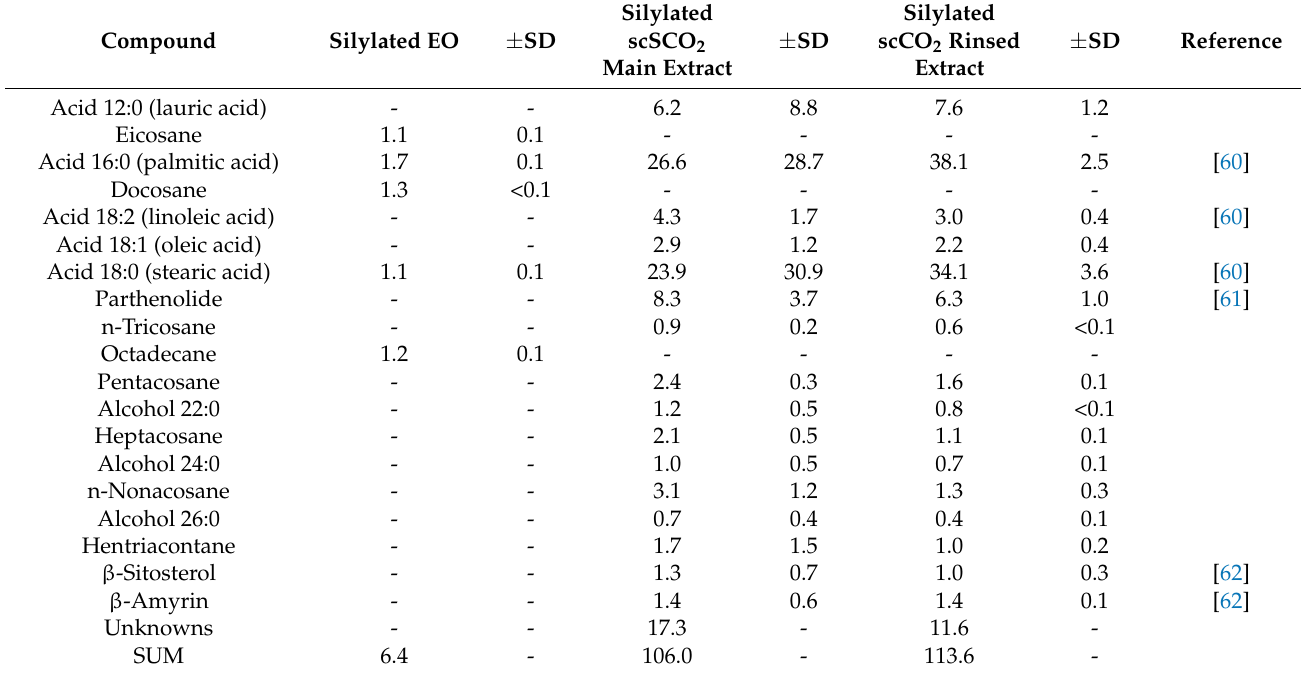
Table 8. The chemical composition (mg/g) of the silylated common tansy inflorescence EO ( 3 ) and scCO 2 extracts ( 6 ).